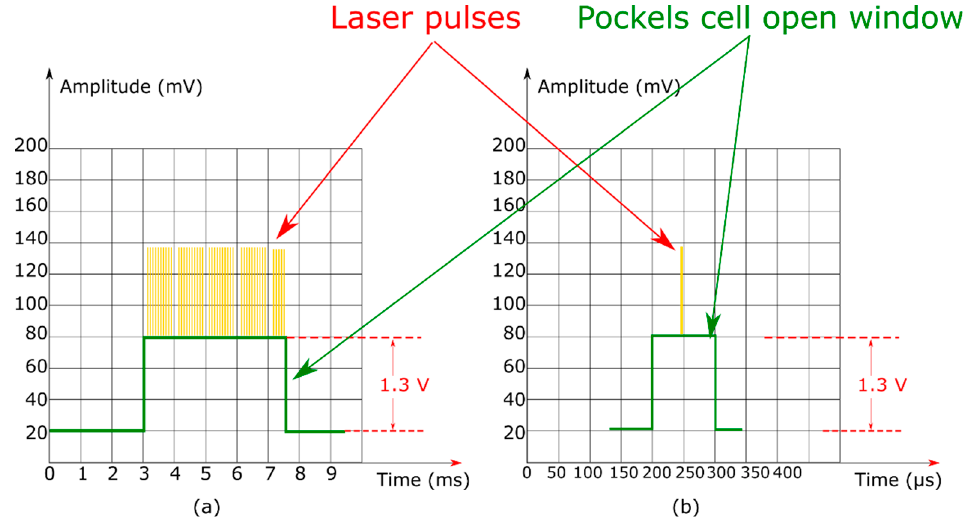
Figure 7. ( a ) Pulses waveform in the entire scanning period; ( b ) pulse waveform in one scanning step.